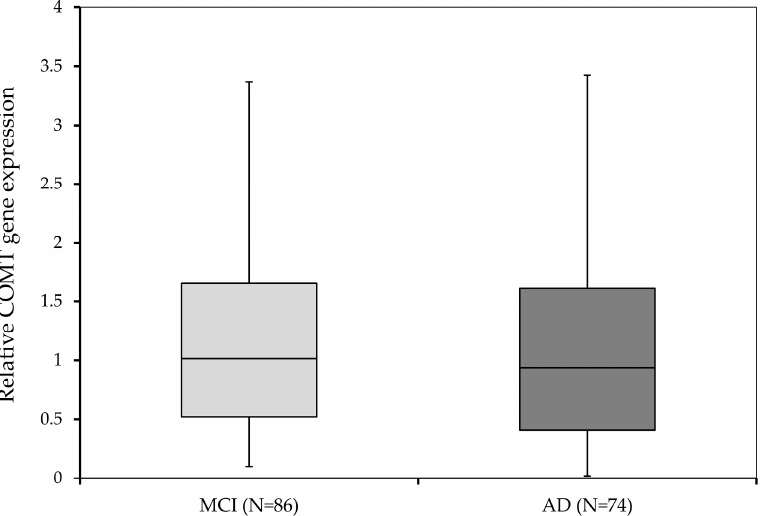
Figure 2. Relative COMT gene expression in subjects with MCI and subjects diagnosed with AD.